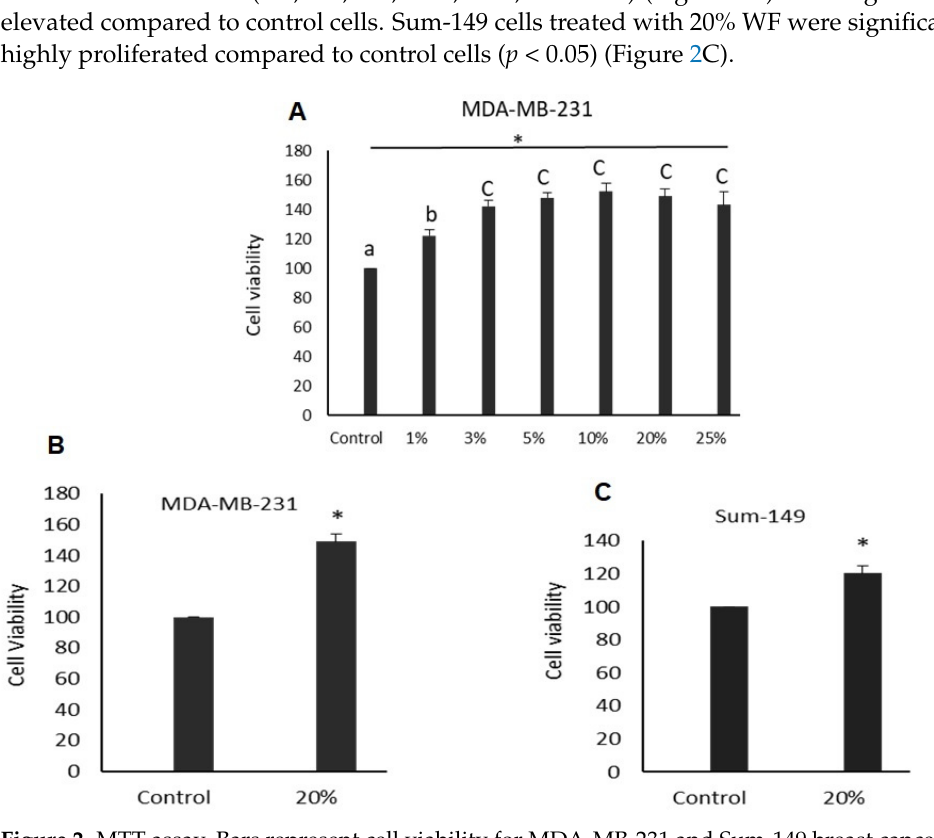
Table 2. Significant cytokines, chemokines, and growth factors. Cytokines, Chemokines, Growth Factors p Value ENA-78 p = 0.035